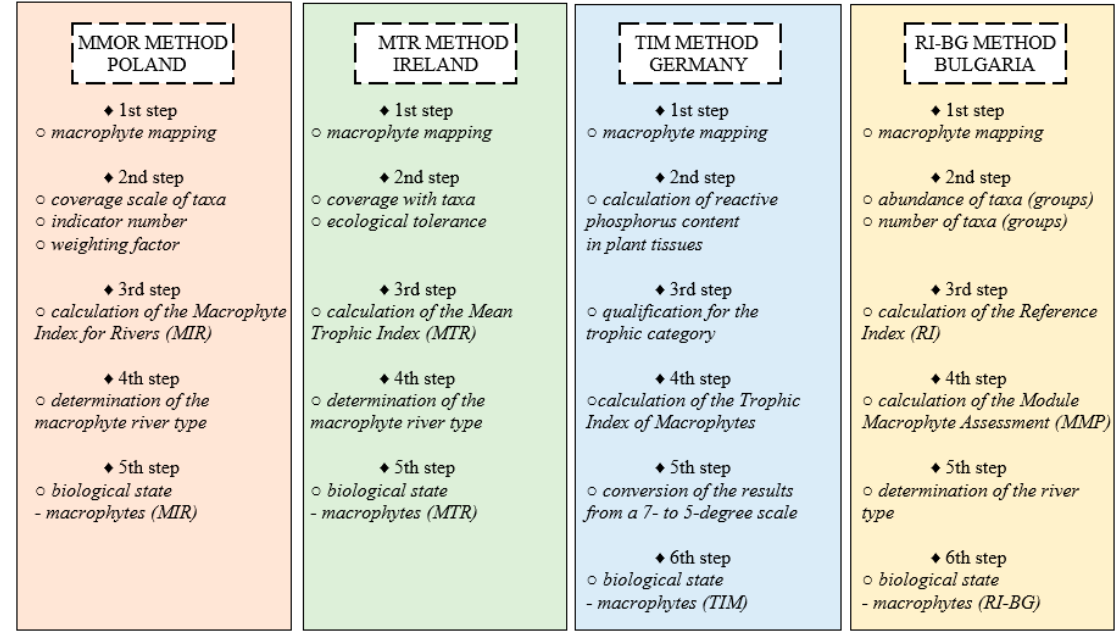
Figure 6. Diagram of the (macrophyte-based) ES analysis process for the described methods (own work).